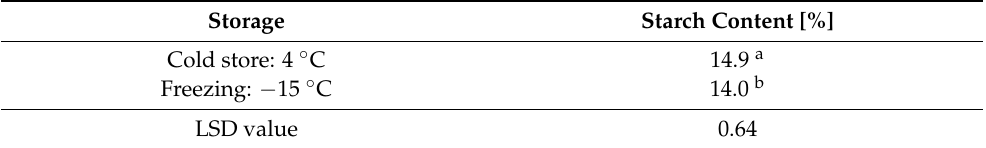
Table 3. Starch contents of frozen and cold-stored potatoes, assessed chemically (homogeneous groups are labeled with the letters).